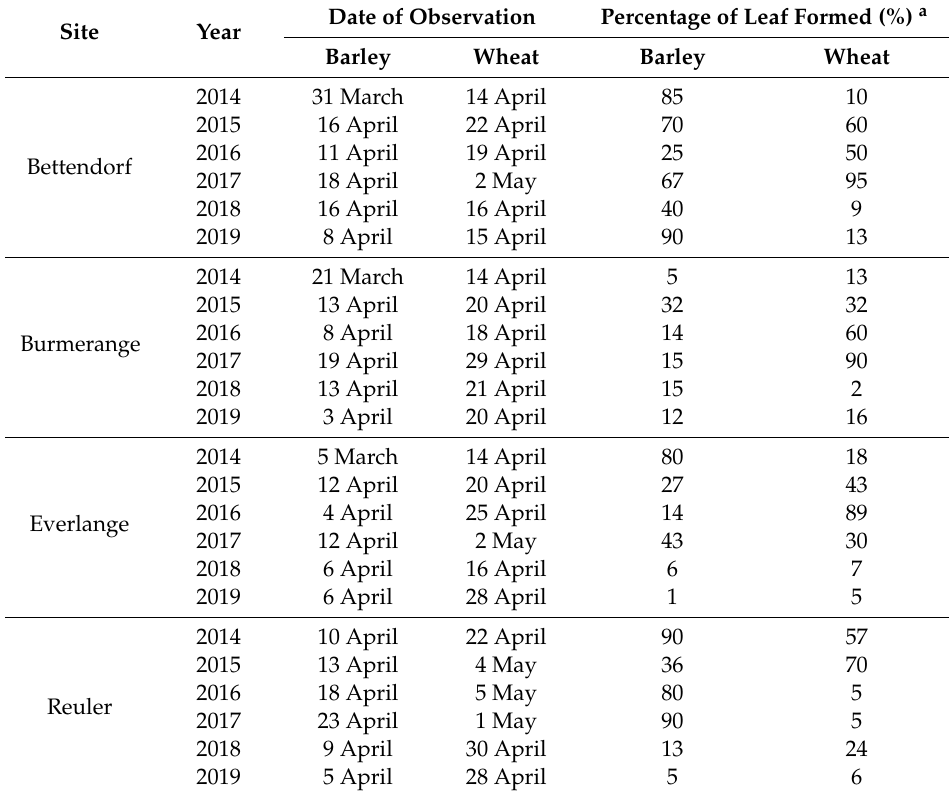
Table 2. Dates of observation and percentage of emerged leaf area for the F-2 leaf (where F = flag) on plants in commercial winter wheat and winter barley fields at the four study sites in the Grand-Duchy of Luxembourg during the 2014–2019 cropping